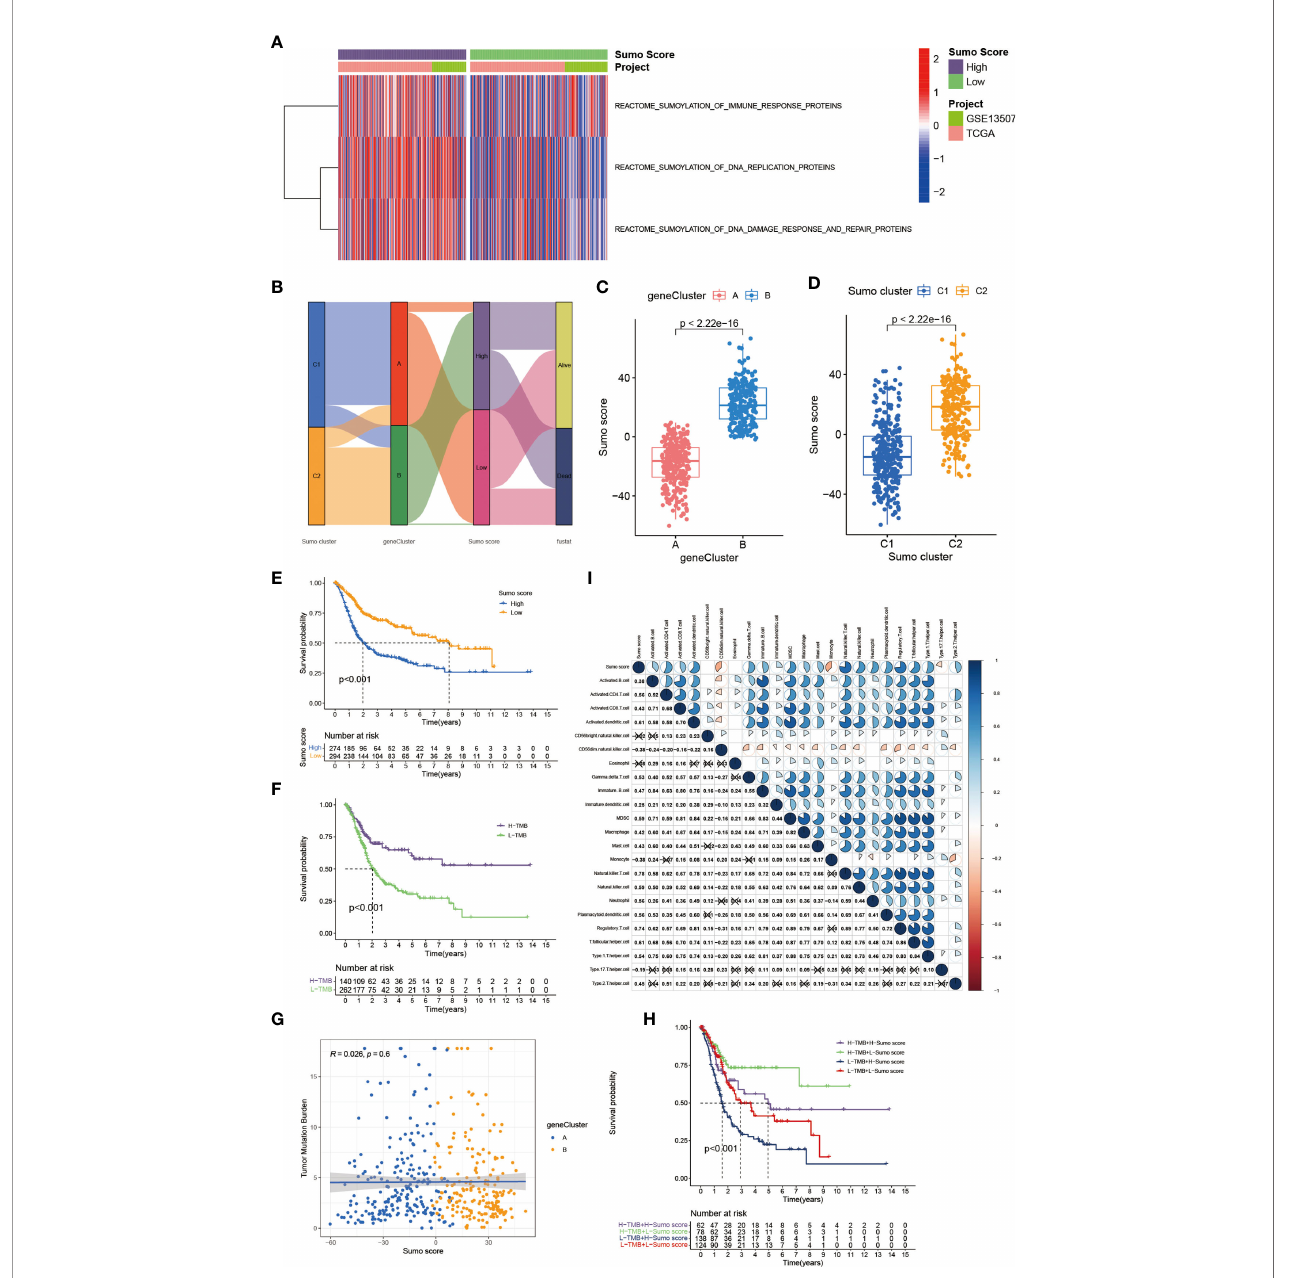
FIGURE 4 | The establishment of SUMO score and its interaction with tumor mutation burden and TME cell in fi ltration. (A) Transcriptome pro fi les of genes involved in SUMOylation related biological processes between patients with high and low SUMO score. (B) Sankey diagram showing the changes of SUMO clusters, gene clusters and SUMO score and fi nal survival status. (C) Differences in SUMO score among two gene clusters in meta-cohort. The Wilcoxon test was used to compare the statistical difference between two gene clusters (P <0.001). (D) Differences in SUMO score among two SUMO clusters in meta-cohort (P <0.001, Wilcoxon test). (E) Survival analyses for low (294 cases) and high (274 cases) SUMO score patient groups in meta-cohort using Kaplan – Meier curves (P <0.001, Log-rank test). (F) Survival analyses for patients with low (262 cases) and high (140 cases) tumor mutation burden in the TCGA-BLCA cohort using Kaplan – Meier curves (P <0.001, Log-rank test). (G) Linear regression analysis for tumor mutation burden and SUMO score. The dot represented each sample, and the color of the dot represented the gene cluster. Blue, gene cluster A; orange, gene cluster B (R = 0.026, P = 0.6). (H) Survival analyses for four groups grouped according to tumor mutation burden and SUMO score in the TCGA-BLCA cohort using Kaplan – Meier curves, namely, 62 cases in high TMB and high SUMO score group, 78 cases in high TMB and low SUMO score group, 138 cases in low TMB and high SUMO score group and 124 cases in low TMB and low SUMO score group. The high TMB and low SUMO score group showed signi fi cantly better overall survival than the other three groups (p <0.001, Log-rank test). (I) Correlations between SUMO score and the known immune cells in meta-cohort using Spearman analysis. Negative correlation was marked with blue and positive correlation with red. The number represented the correlation coef fi cient and the cross meant lack of statistical signi fi